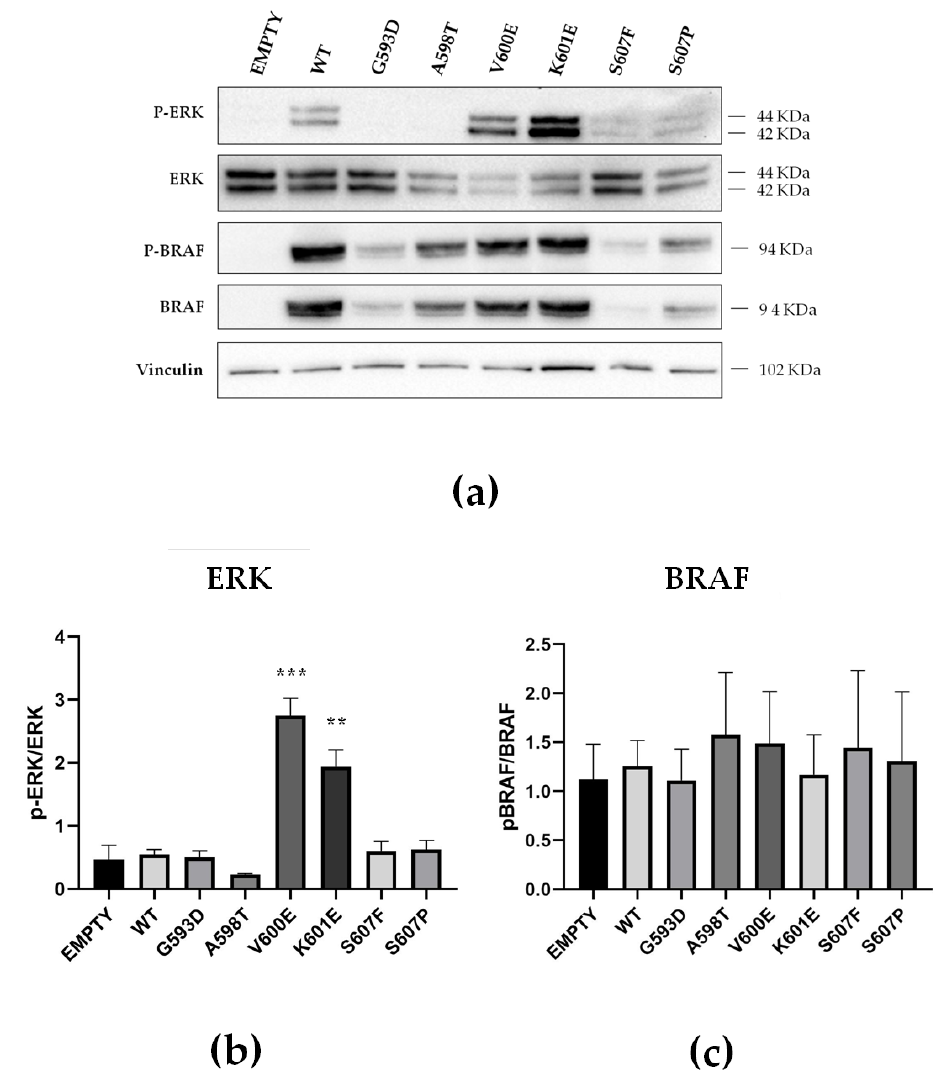
Figure 4. Functional characterization of BRAF p.G593D, BRAF p.A598T, BRAF p.S607F, and BRAF p.S607P compared to BRAF wild type (WT), BRAF p.V600E, BRAF p.K601E, and empty vector (EMPTY). ( a ) E ff ect of BRAF mutation on the MAPK signaling pathway: representative Western Blot of